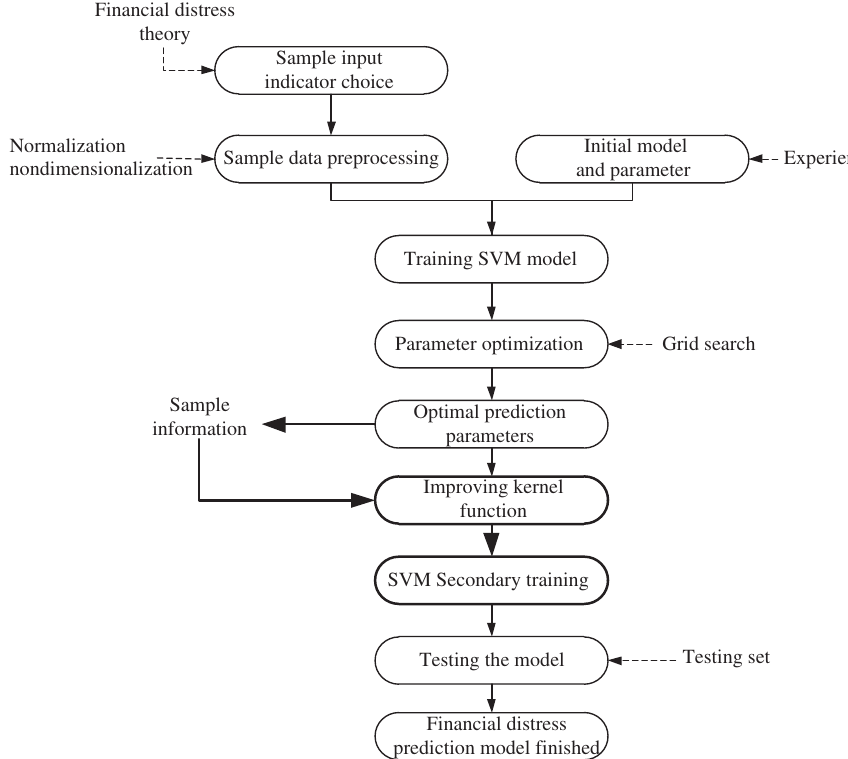
Figure 2: The SVM Financial Distress Prediction Model Improved the Kernel Function.